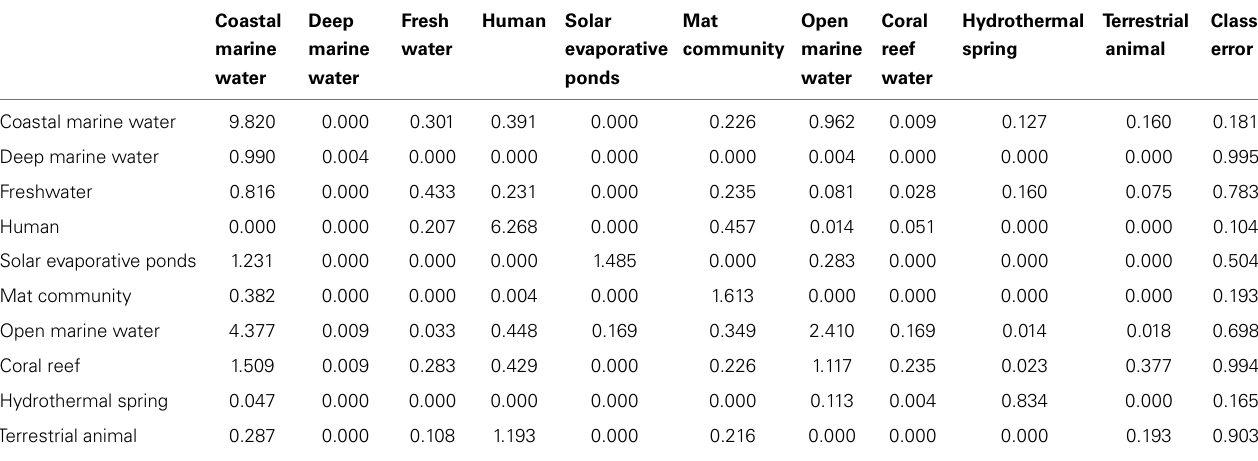
Table 4 |The misclassification table generated by the canonical discriminant